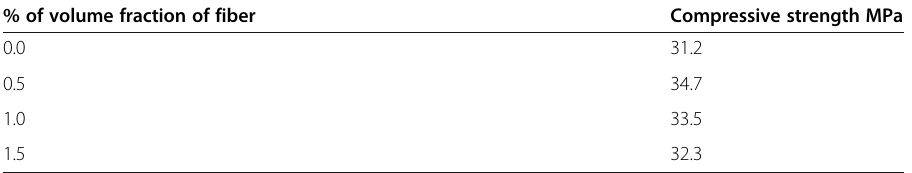
Table 5 Compressive strength of GPC with and without PPF % of volume fraction of fiber